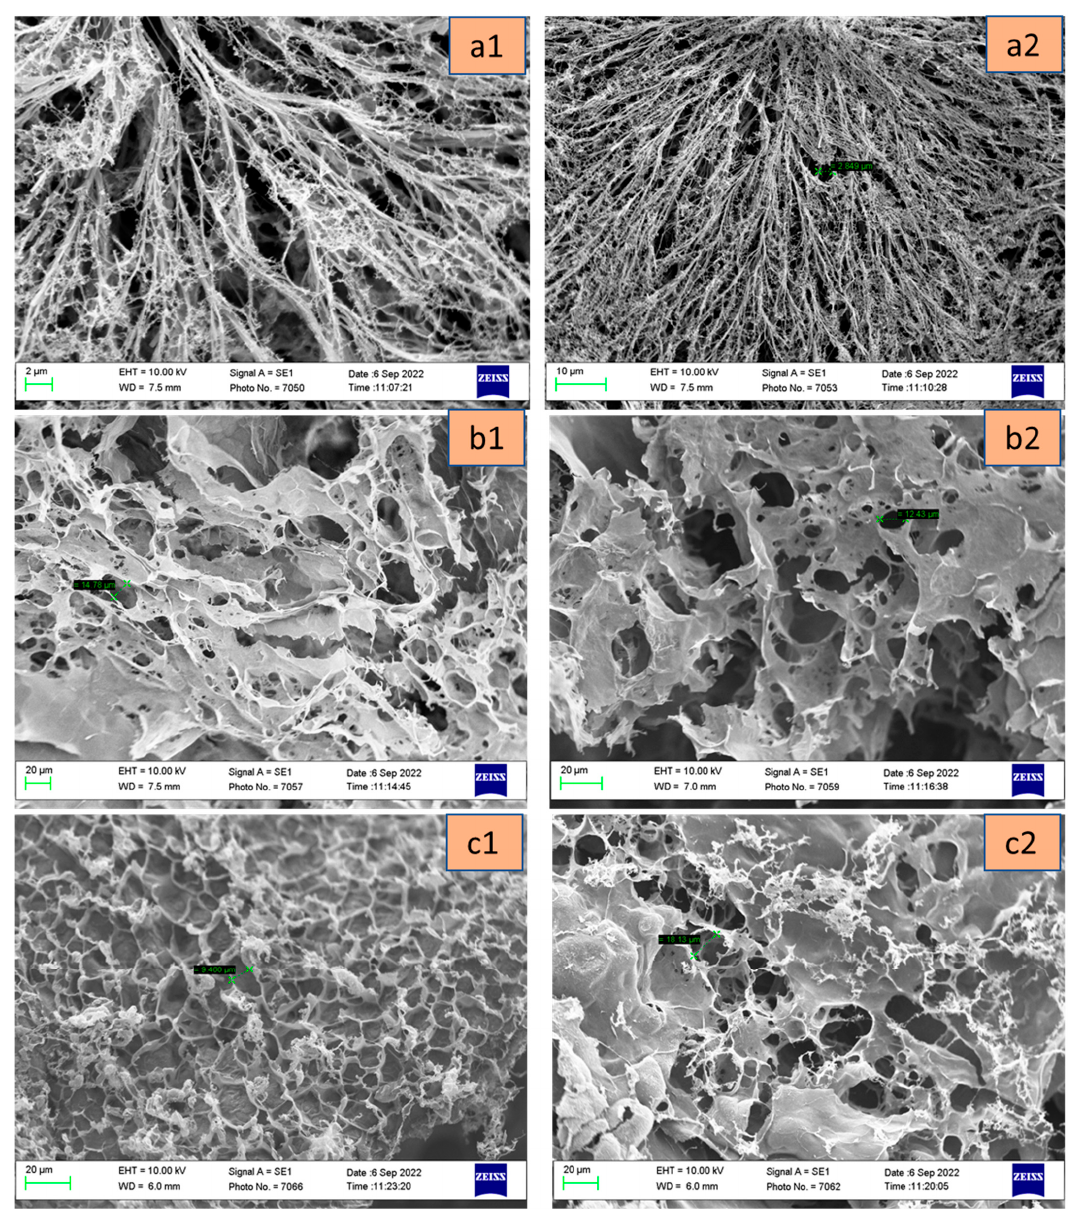
Figure 11. SEM structures of freeze-dried chitosan hydrogels M1 ( a1 , a2 ), M2 ( b1 , b2 ), and M3 ( c1 , c2 ) at different magnifications.